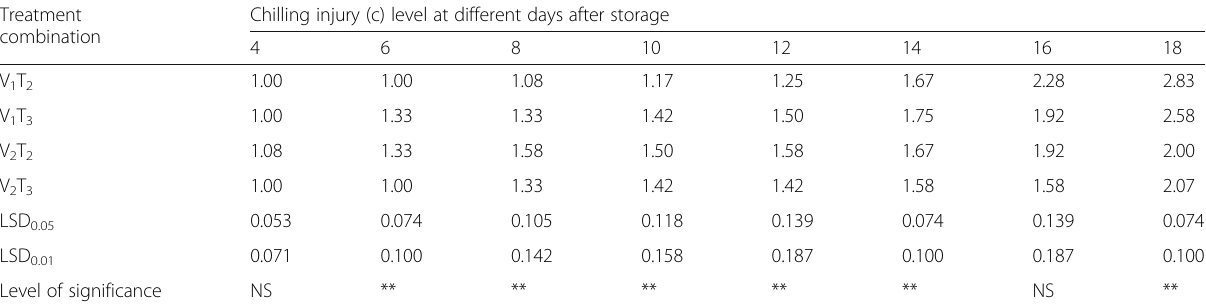
Table 7 Combined effect of varieties and different postharvest treatments on chilling injury level of tomato during storage and ripening Treatment